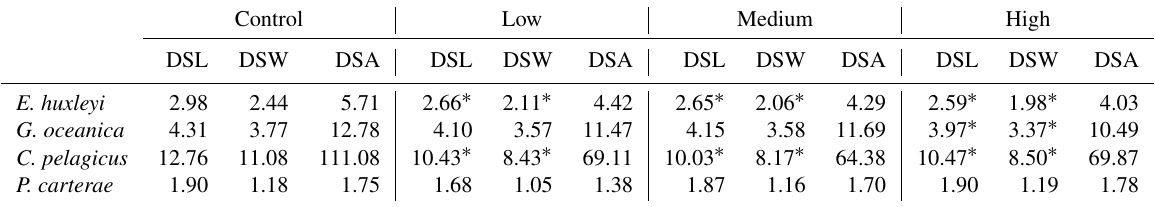
Table 3. Coccolith distal shield length (DSL, µm) and distal shield width (DSW, µm) average values and calculated distal shield area (DSA, µm 2 ) for all experiments. Asterisks indicate significant difference from the control treatment. Significance of DSL and DSW was tested using an ANOVA and a Tukey post-hoc test ( p <0.05). Asterisks indicate significant difference from the control